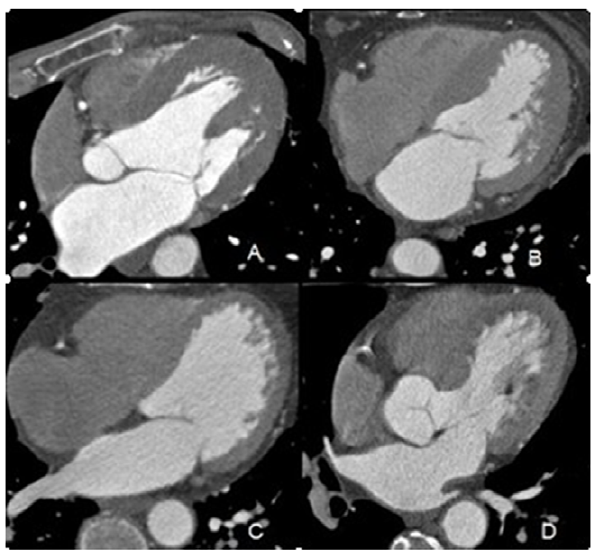
Figure 1. Axial A-D of middle segment of the RCA are respectively scored as 4–1: 4, excellent, no artifacts; 3, good, mild artifacts; 2, acceptable, moderate artifacts, but can still make a diagnosis; and 1, cannot evaluate, severe artifacts, cannot make a diagnosis.